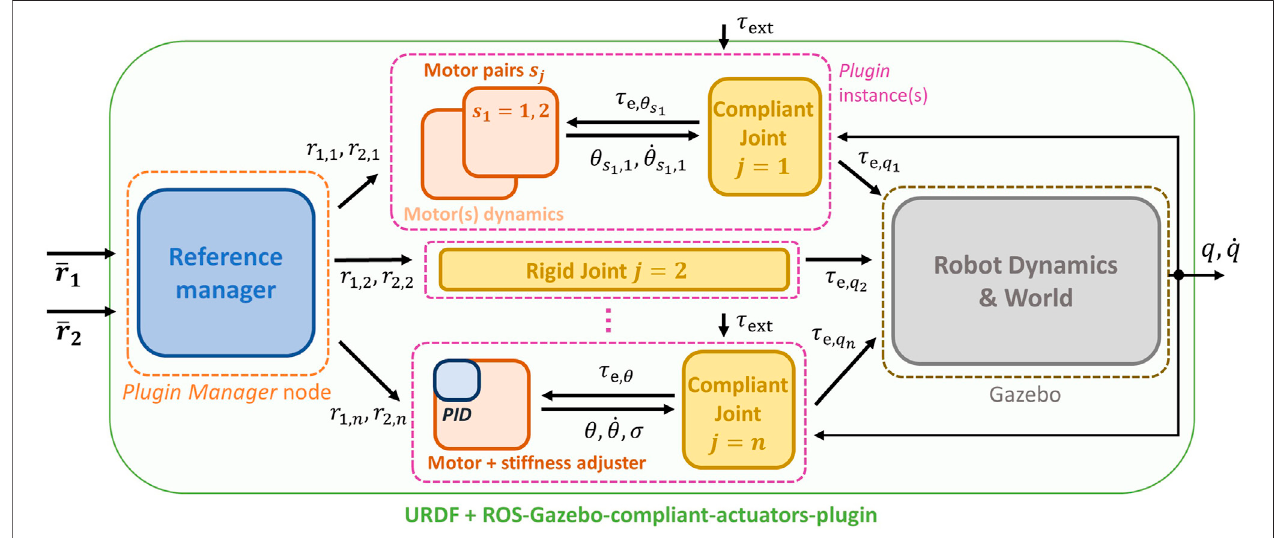
FIGURE 3 | Scheme of the proposed toolbox integrated into the ROS-Gazebo framework, with main state and control variables exchanged between the components of the plugin and the node. Different compliant joints can be simulated as well as rigid ones, with and without motor dynamics and low-level PID control.